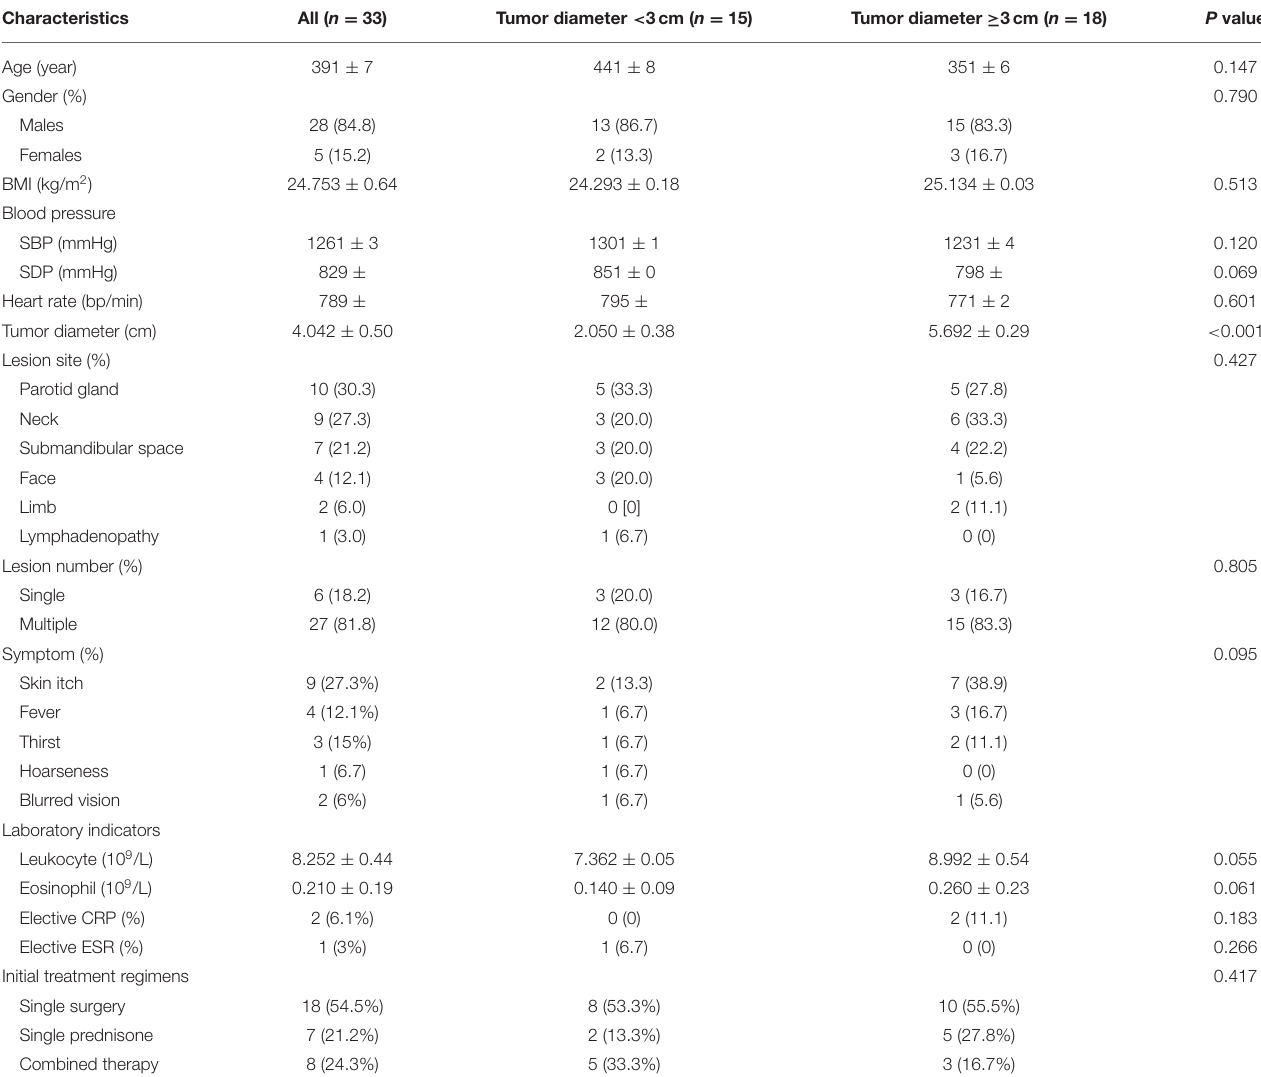
TABLE 1 | Clinical features, laboratory indicators, and initial treatment regimens in patients with Kimura disease and different diameters of tumors.